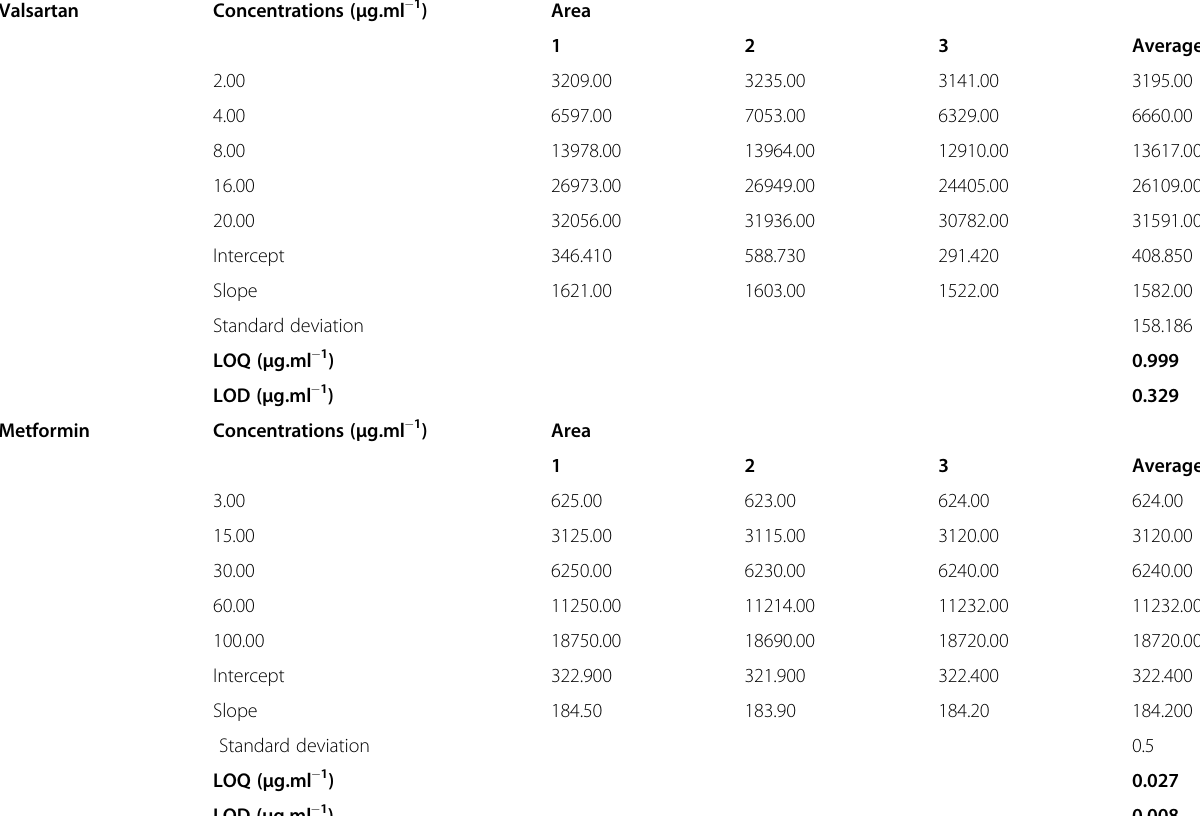
Table 2 System suitability: valsartan-metformin